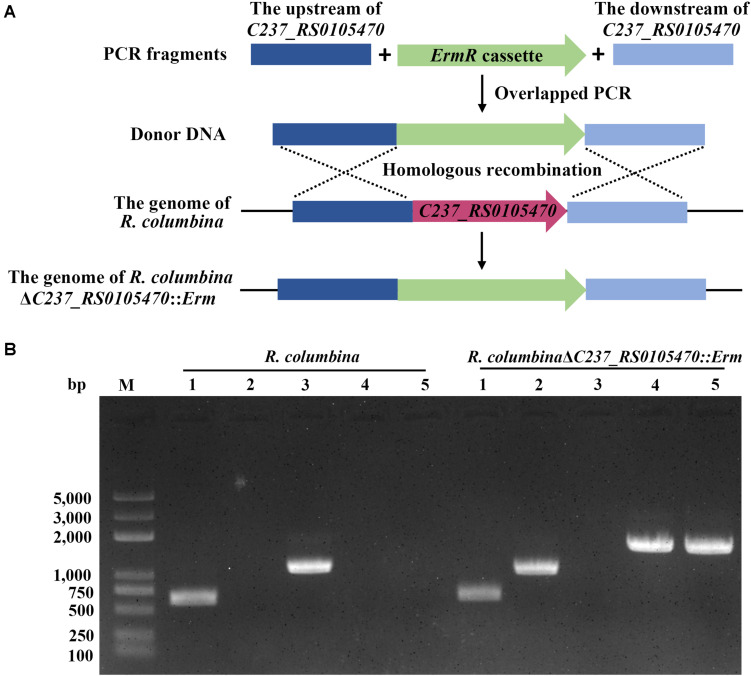
Verification of the mutant strain R. columbinaΔC237_RS0105470::Erm. (A) Schematic diagram of donor DNA preparation and gene deletion based on natural transformation. (B) The identification of the R. columbinaΔC237_RS0105470:Erm mutant strain by PCR. Lane M, MD103 DNA marker (BioMed, Beijing, China). Lane 1, the 16S rRNA was amplified from wild-type R. columbina and the mutant strain R. columbinaΔC237_RS0105470::Erm using the primers RC-16S rRNA P1 and RC-16S rRNA P2. Lane 2, the erythromycin resistance cassette was amplified from wild-type R. columbina and the mutant strain R. columbinaΔC237_RS0105470::Erm using the primers RC-Erm P1 and RC-Erm P2. Lane 3, the target gene C237_RS0105470 was amplified from wild-type R. columbina and the mutant strain R. columbinaΔC237_RS0105470::Erm using the primers C237_RS0105470 P1 and C237_RS0105470 P2. Lane 4, the upstream sequence and erythromycin resistance cassette was amplified from wild-type R. columbina and the mutant strain R. columbinaΔC237_RS0105470::Erm using the primers RC-Up P1 and RC-Erm P2. Lane 5, the erythromycin resistance cassette and downstream sequence was amplified from wild-type R. columbina and the mutant strain R. columbinaΔC237_RS0105470::Erm using the primers RC-Erm P1 and RC-Down P2.